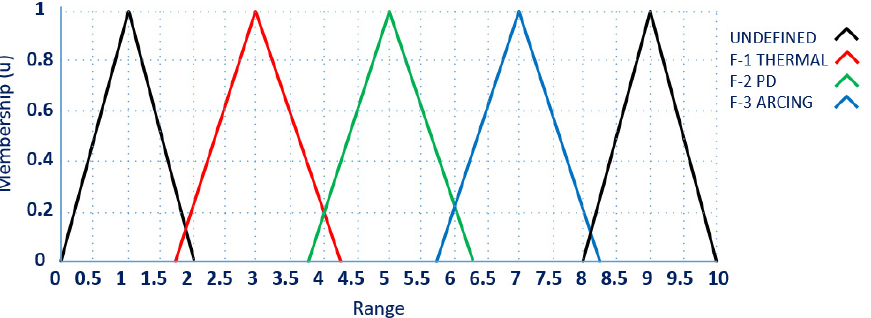
Figure 3. Output membership